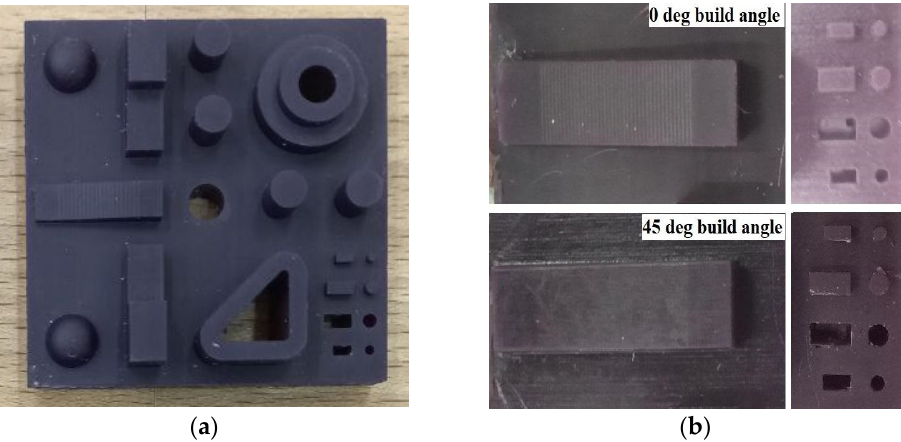
Figure 6. ( a ) Printed pattern. ( b ) Ramps and fine features printed at 0 and 45 degrees of build angle.